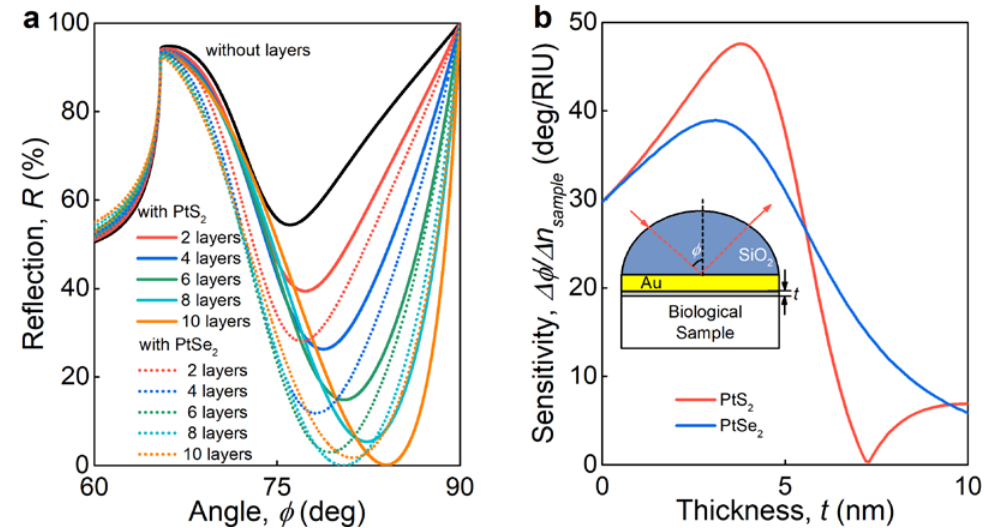
Figure 4. Surface plasmon resonance (SPR) biosensor based on PtS 2 and PtSe 2 . ( a ) The reflectance spectra of SPR sensor for different layer numbers of PtS 2 and PtSe 2 . ( b ) The dependence of the SPR sensor sensitivity on PtS 2 and PtSe 2 thickness. The inset is a schematic configuration of an SPR sensor. Calculations performed at 635 nm wavelength.